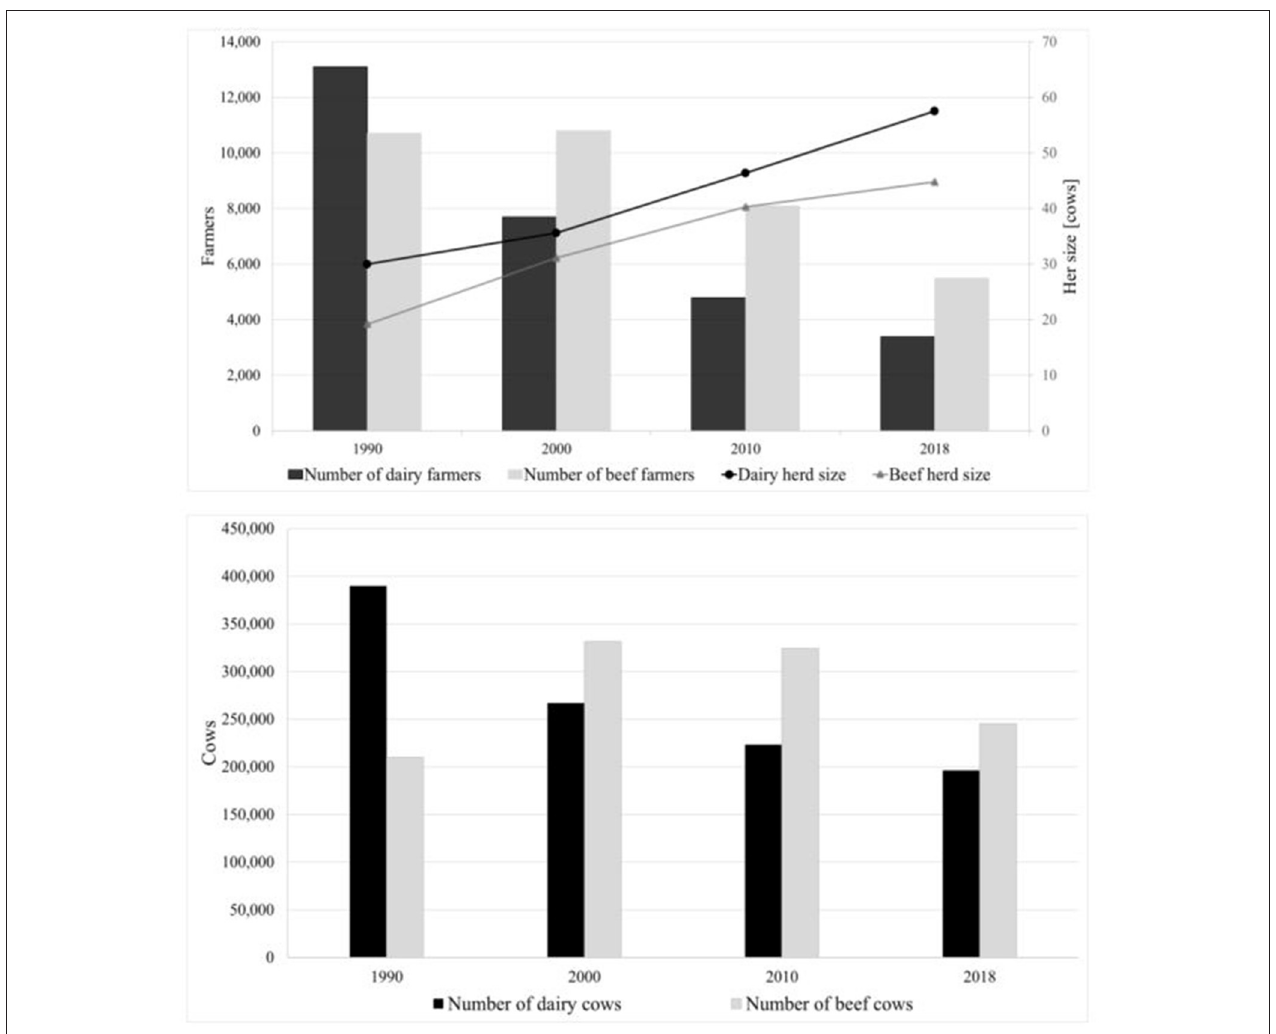
FIGURE 1 | Key features of the Walloon beef and dairy sectors (SPW,